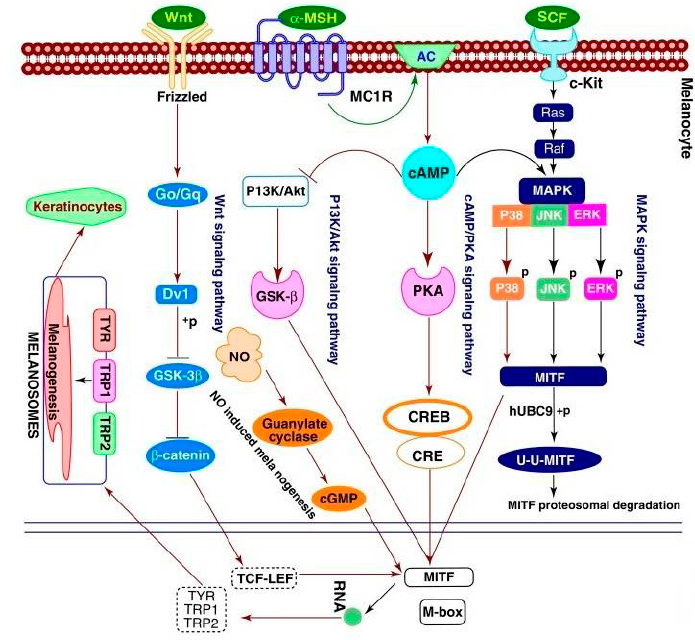
Figure 2. Regulation of melanogenesis through different signaling pathways [18,19].